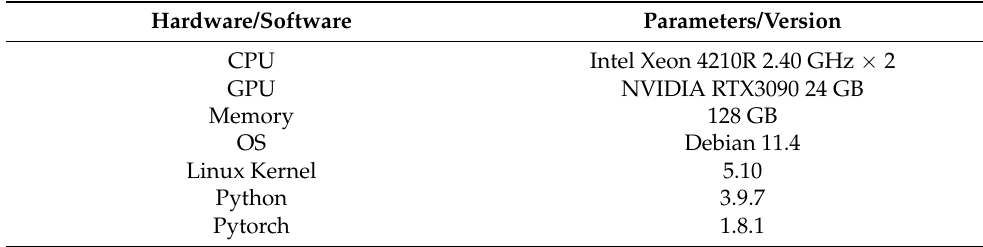
Table 2. The configuration of the